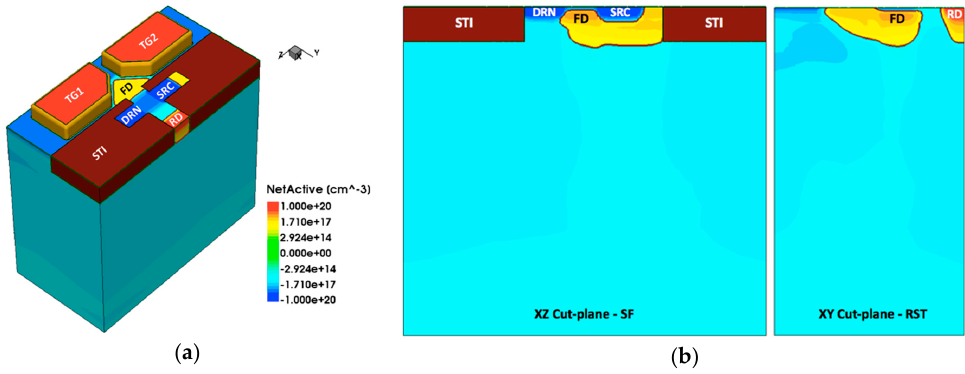
Figure 14. ( a ) 3D doping profile of JFET jot device from TCAD simulation; ( b ) Cross-section doping profiles of JFET SF region.